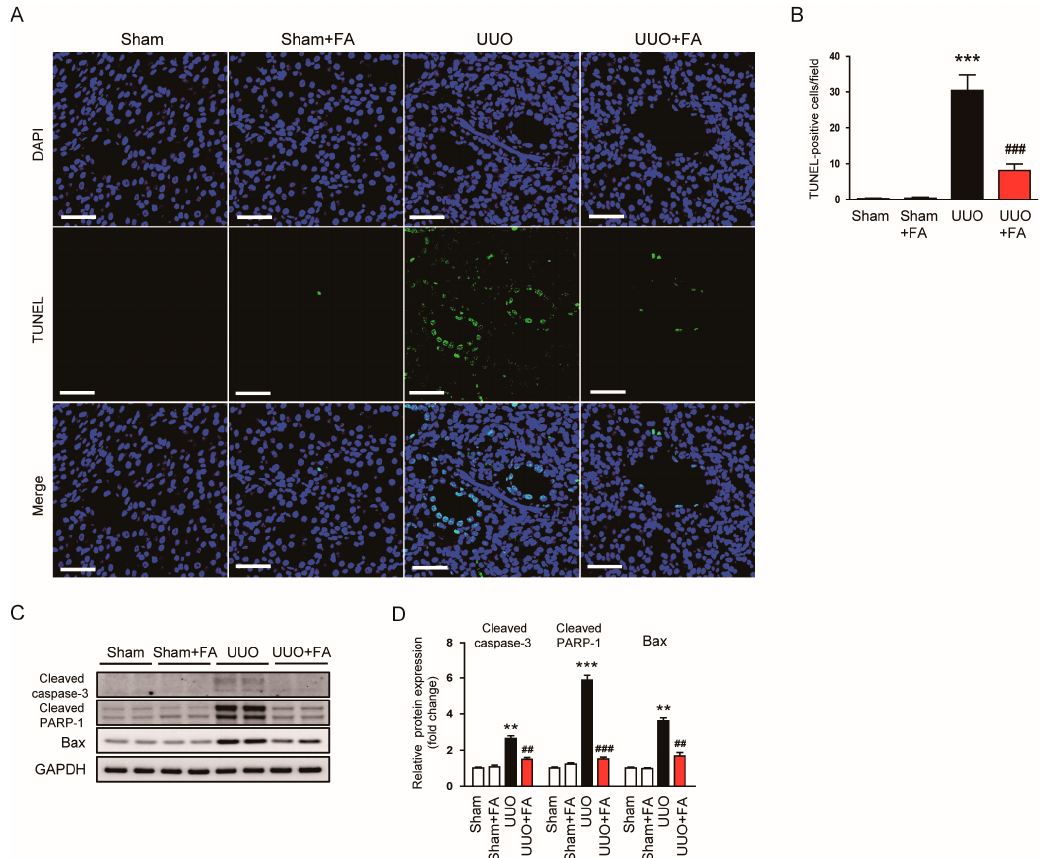
Figure 8. Effects of FA on apoptotic cell death in UUO mice. ( A ) TUNEL staining. Scale bar = 50 µ m. ( B ) Number of TUNEL-positive cells. ( C ) Western blotting of cleaved caspase-3, cleaved PARP-1, and Bax. ( D ) Quantification of Western blots for cleaved caspase-3, cleaved PARP-1, and Bax. ** p < 0.01 and *** p < 0.001 vs. Sham. ## p < 0.01 and ### p < 0.001 vs. UUO. Macrophage infiltration is an important process in obstructive uropathy [41,42]. To examine the effect of FA on macrophage infiltration, we first measured the renal activity of MPO in each group. MPO is an enzyme secreted by activated macrophages [43]. Renal MPO activity was increased after the UUO operation (Sham, 0.8 ± 0.1 U/g protein vs. UUO, 4.8 ± 0.4 U/g protein, p < 0.001) (Figure 10A). When UUO mice were treated with FA, renal MPO activity was significantly inhibited (UUO, 4.8 ± 0.4 U/g protein vs. UUO + FA, motif chemokine ligand 5 (CXCL5) and monocyte chemoattractant protein-1 (MCP-1) was also significantly reduced by FA (CXCL5: UUO, 18.9 ± 2.6 vs. UUO + FA, 7.2 ±